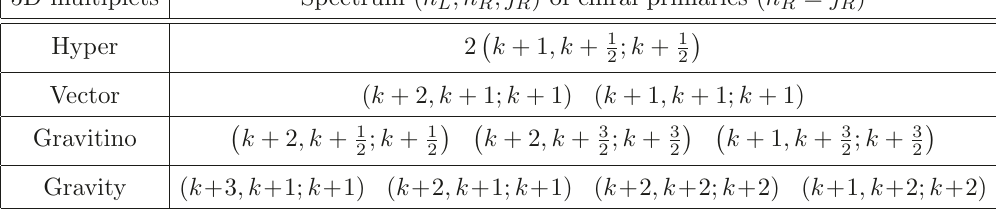
Table 5 . The spectrum of chiral primaries on AdS A standard computation (see e.g. [44]) yields the spectrum of chiral primaries for the AdS 3 S 2 compactification of 5D supergravity given in table 5. We want to deduce the × implications of this spectrum on AdS 3